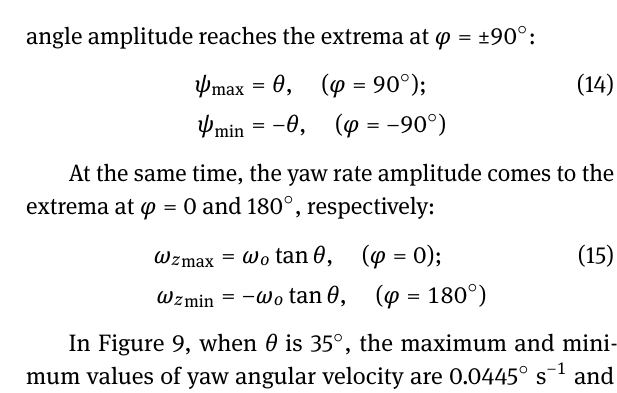
From Eqs. (8), (11) and (12), the yaw rate ω z can be presented as: